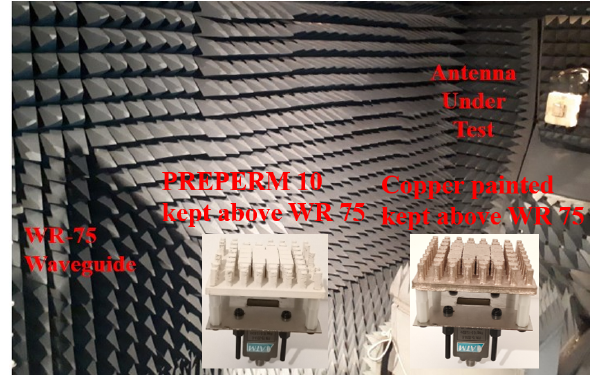
Figure 9. Experimental setup of the measurement